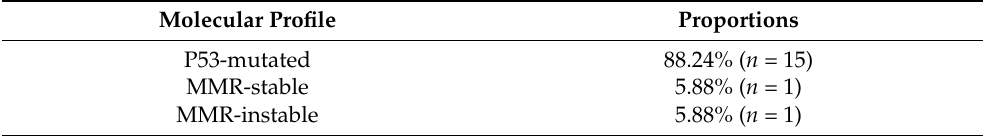
Table 6. Serous endometrial cancer types according to molecular profiles.